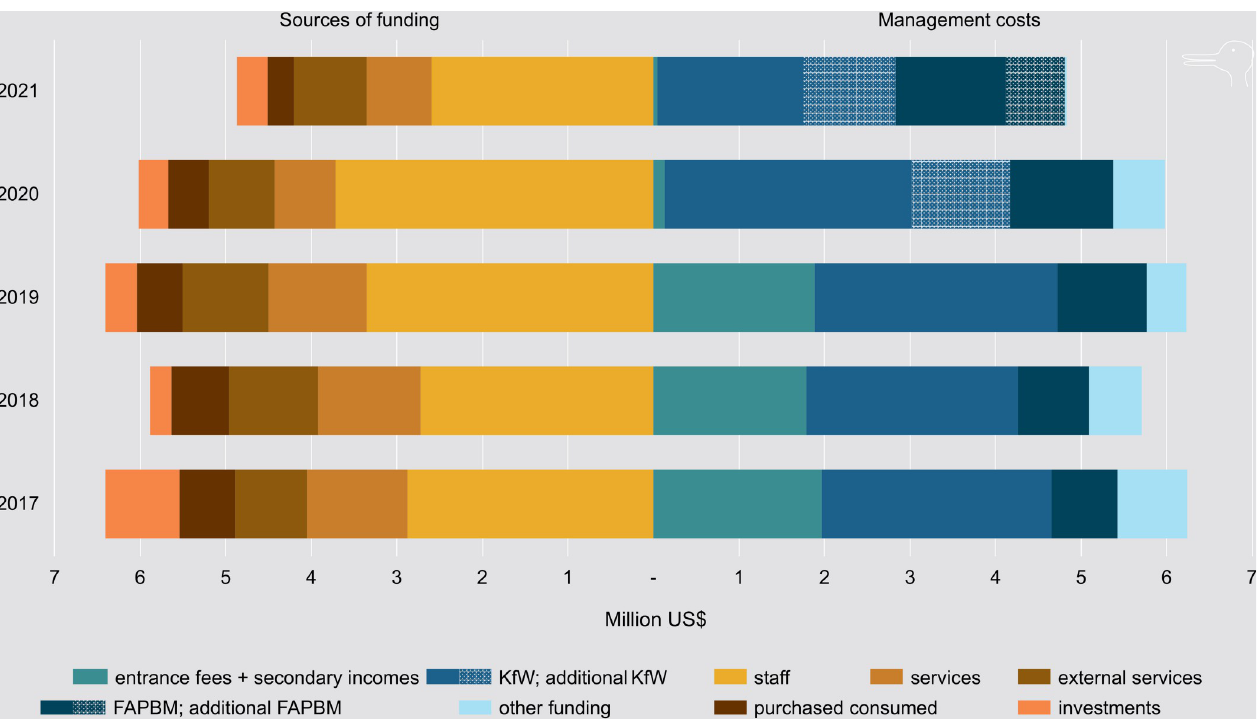
Fig 5. PA funding Madagascar. MNP funding for parks and reserves in categories I, II and IV—in million US$ dollar equivalents; the losses of entrance permit ticket sales for PAs managed by MNP have been estimated as being between US$ 3.7 and 5.9 million for 2020 and 2021—US$ 2,268,358—min = US$ 1,746,272; max = 2,855,348—in 2020 and US$ 2,415,991—min = US$ 1,878,324; max = 3,019,958—in 2021).